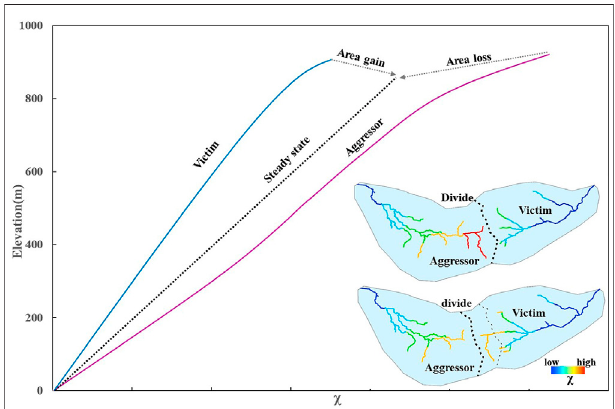
FIGURE 2 | River basins and river pro fi les in equilibrium and disequilibrium. The parameter χ predicts the steady-state elevation for a given point on a channel. The basin on the left (aggressor) has lower steady-state elevation at channel heads and therefore drives the drainage divide toward the basin on the right (victim) (modi fi ed from Willett et al., 2014).